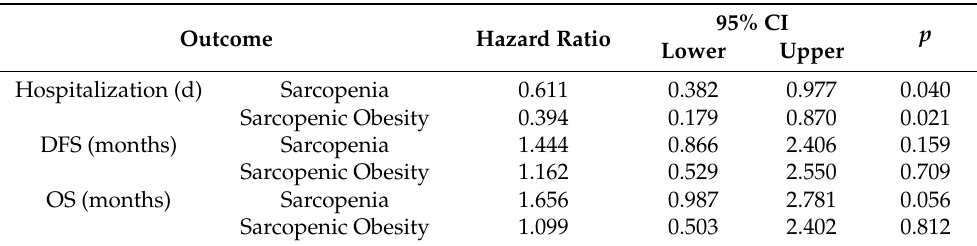
Table 4. Correlation analysis of sarcopenia and sarcopenic obesity to postoperative outcome parame- ters. Outcome